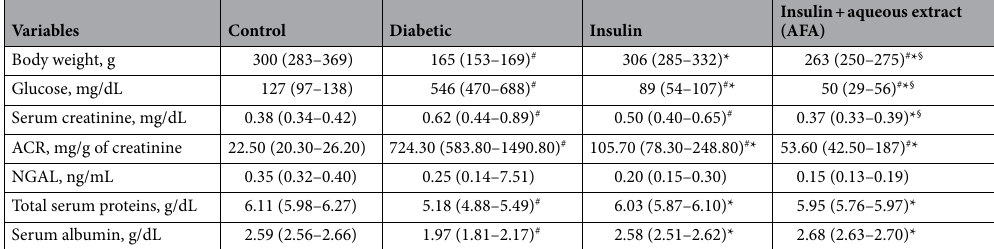
Table 1. Body weight and biochemical analyses of control, diabetic, and treated diabetic groups. Results are expressed as the median (interquartile range). ACR urinary albumin/creatinine ratio, NGAL neutrophil gelatinase-associated lipocalin. # P < 0.05, vs. control group; *P < 0.05, diabetic group; § P < 0.05, insulin